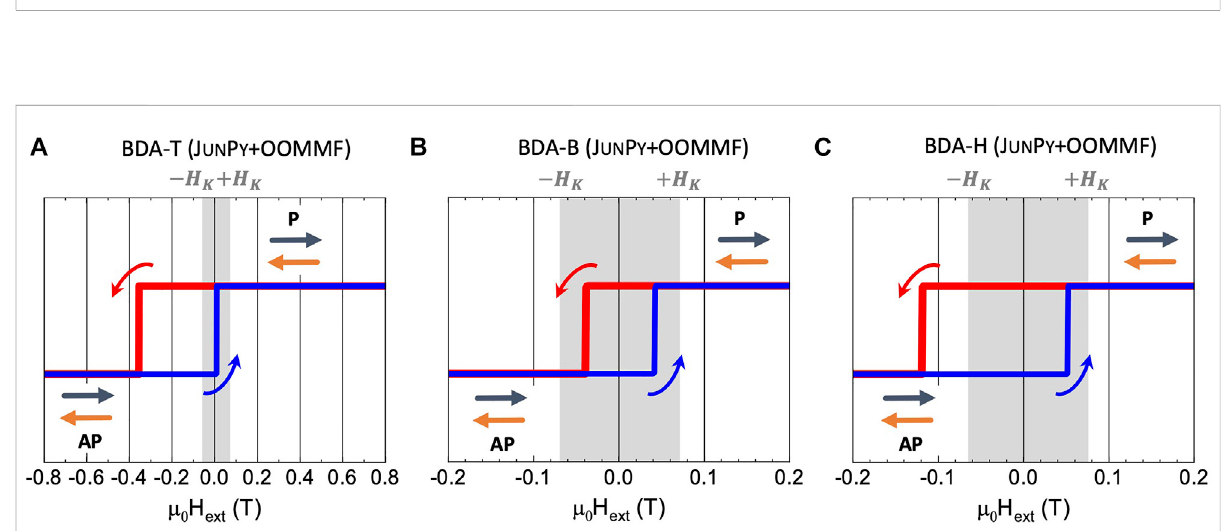
H k .Thered(blue)curvedarrowisthe 0